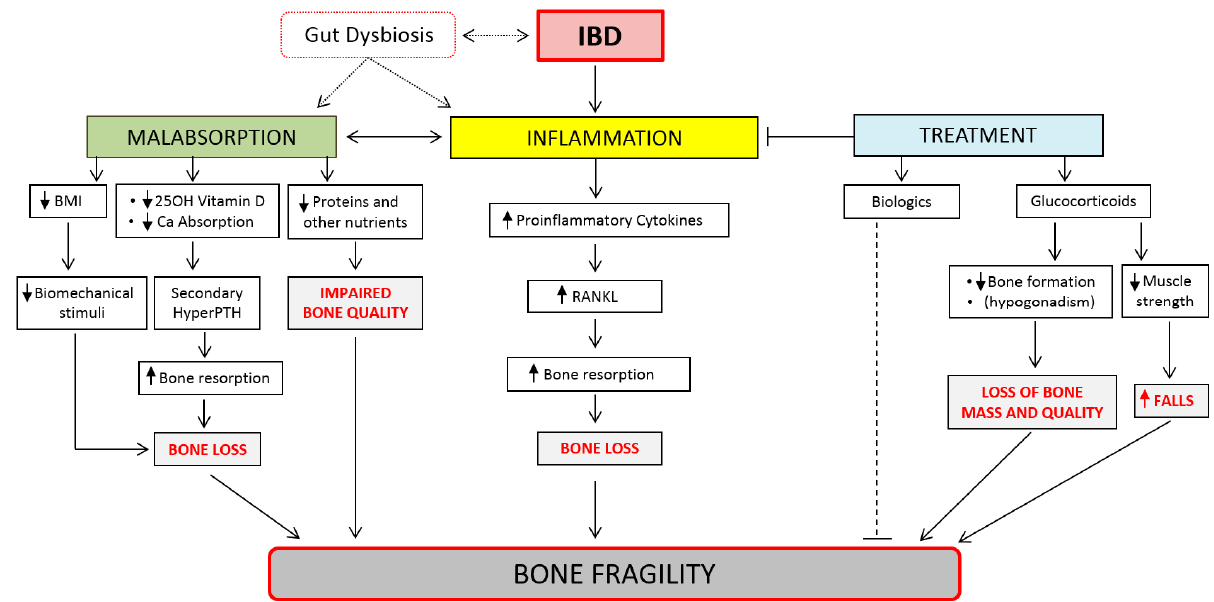
Figure 1. Pathophysiology bone fragility induced by Inflammatory Bowel Disease (IBD). (HyperPTH: hyperparathyroidism).